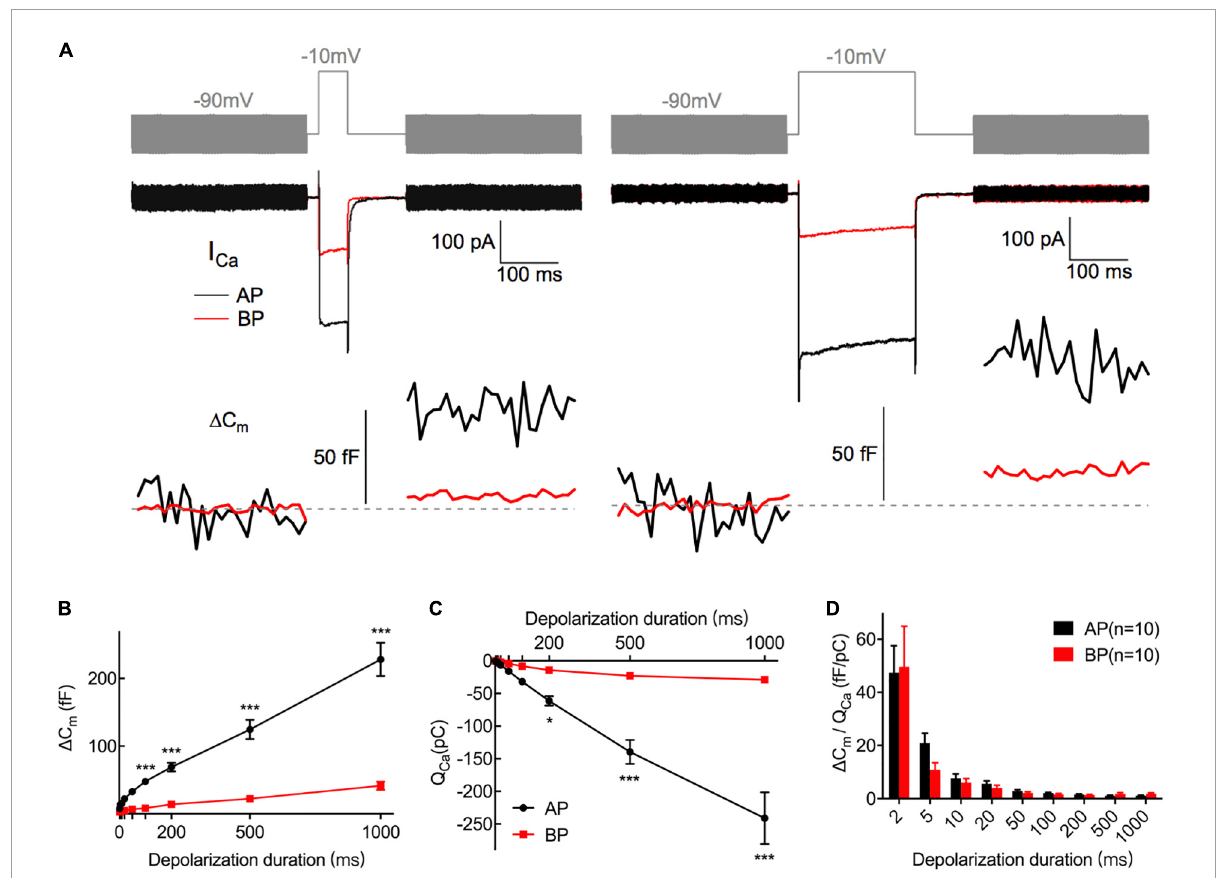
FIGURE4 Exocytosis recorded by C m measurements from hair cells. (A) Plotted are representative individual capacitance increase ( (cid:49) C m ) and the corresponding I Ca in an AP (black) and a BP (red) hair cell. The top trace (gray) shows the stimulus, in which the thick line represents a sine wave that is blanked during the depolarizing step. The middle trace shows I Ca ; exocytotic (cid:49) C m traces are seen in the bottom panel, with the blank region representing a depolarizing step of 50 (left) and 200 ms (right), respectively. Horizontal dashed lines represent normalized C m before stimulation. (B,C) (cid:49) C m values (B) and Ca 2 + charge (Q Ca ) (C) measured from AP and BP hair cells in response to increasing stimulation durations from 2 ms to 1 s, including 2, 5, 10, 20, 50, 100, 200, 500, and 1,000 ms. (D) Ca 2 + efficiency in triggering exocytosis, assessed by the ratio of (cid:49) C m /Q Ca , was found no significant difference in response to all the above stimulations. Values are presented as mean ± SEM and evaluated with two-way ANOVA followed by the Bonferroni post-hoc test. * p < 0.05, *** p < 0.001, **** p < 0.0001; n = 10 per